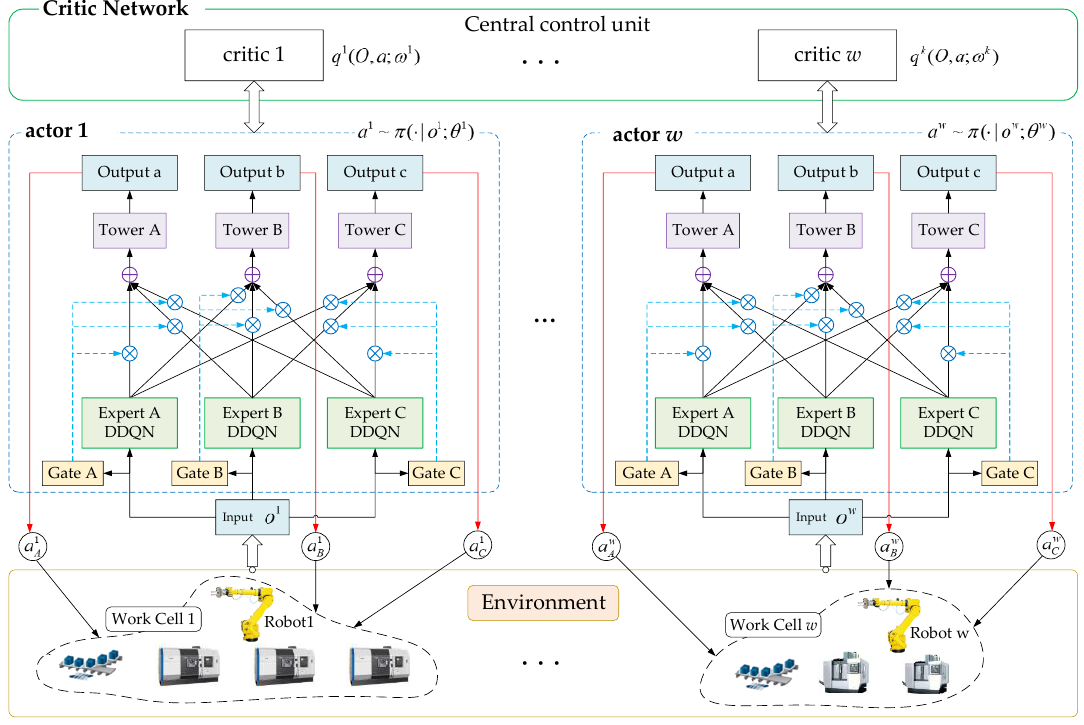
Figure 5. Scheduling decision framework.